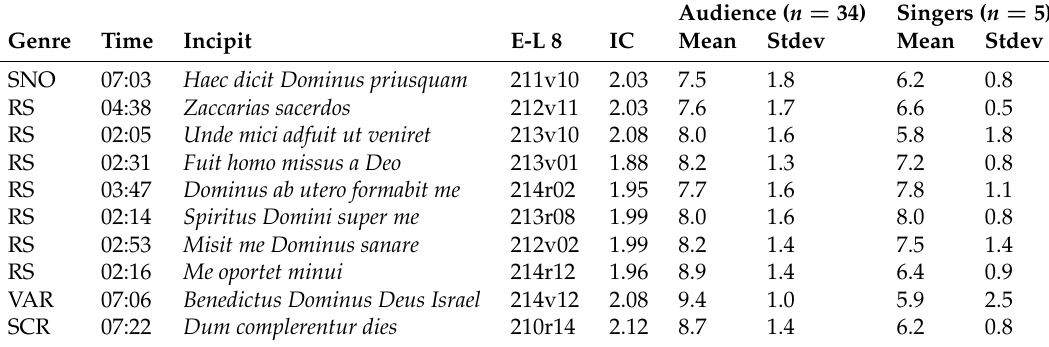
Table 3. Chants performed at the concert, including genre (SNO: sono; RS: responsory; VAR: various; SCR: sacrificium), performance time, name of template, place in E-L 8, and for the generated performance score (see Results), IC (bits/event), audience and singer